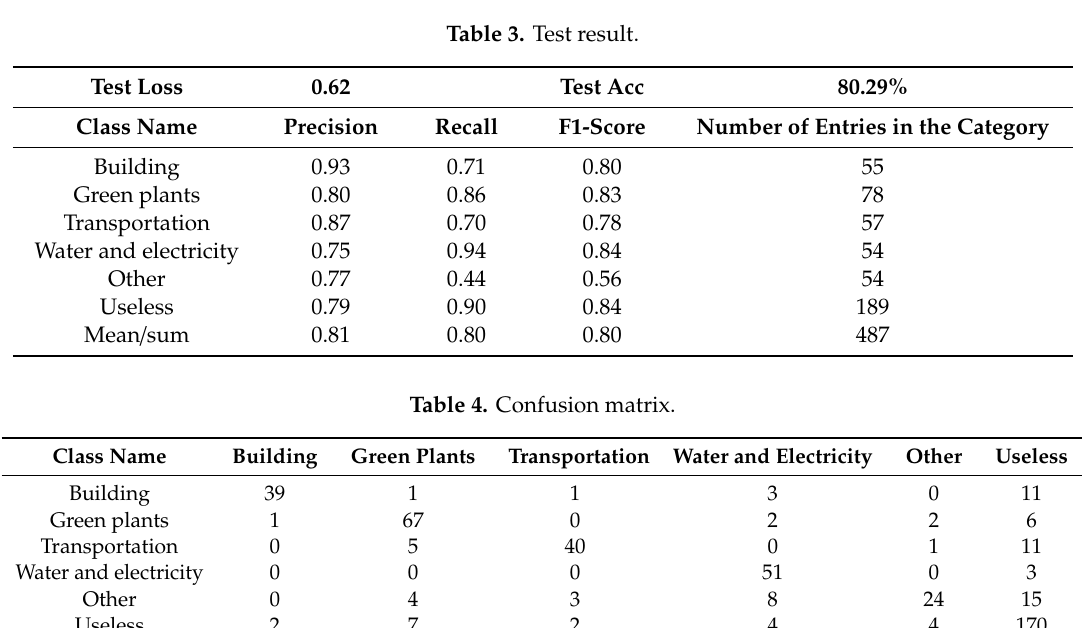
Figure 8. Accuracy and number of trainings.